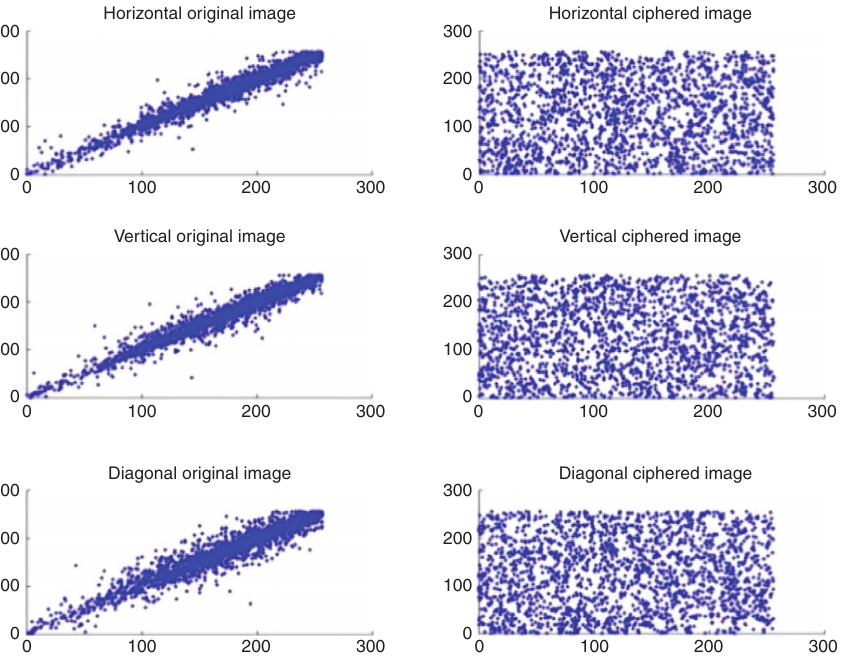
Figure 14: Plot Describes Correlation Horizontally, Vertically and Diagonally for Two Adjacent Pixels in Plain and Encrypted Camera Man Image. Table 1: Correlation Coeflcient Values for Original Images and their Corresponding Ciphered